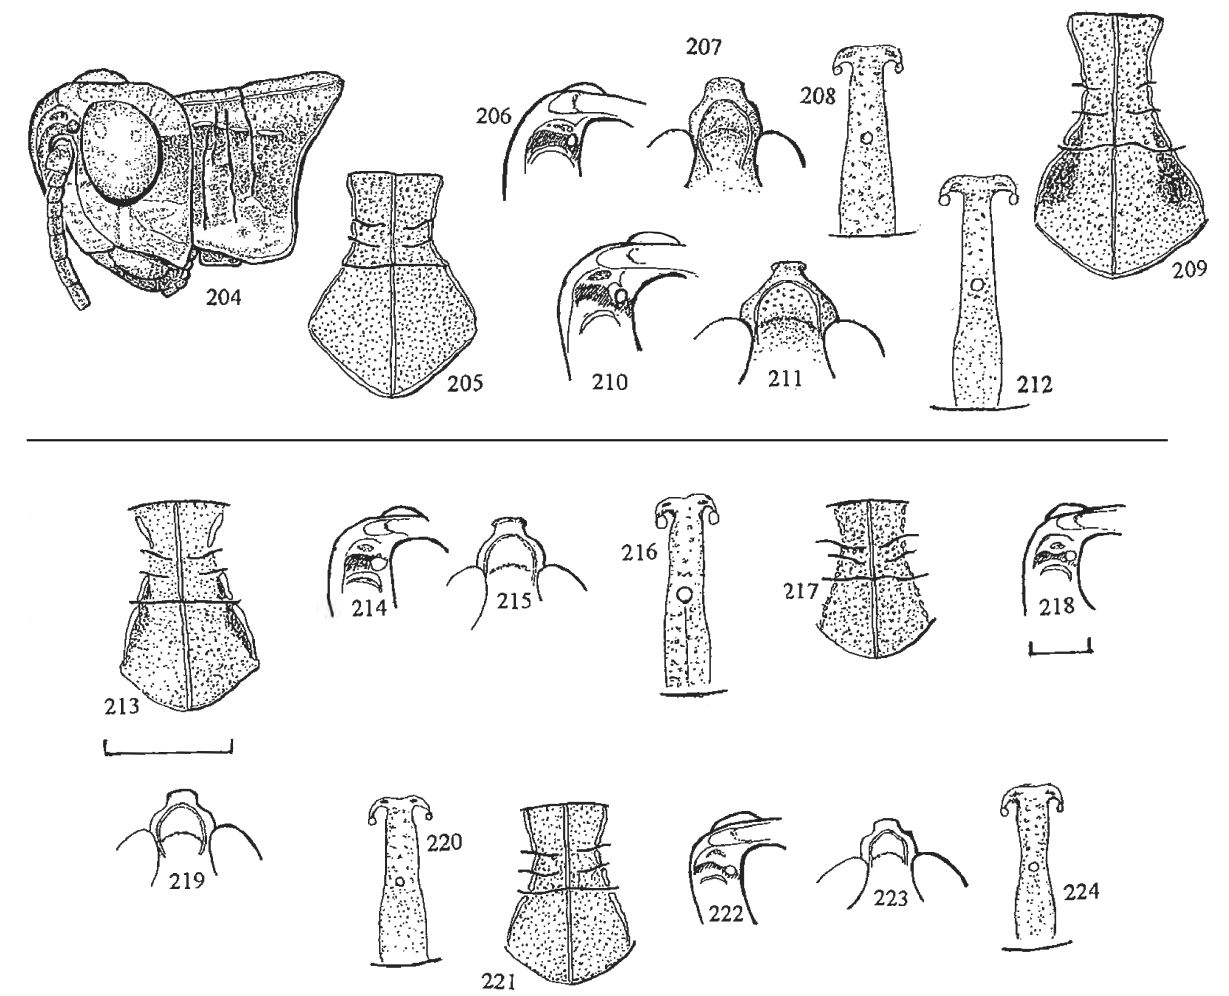
Figs 204–224. Tribe Gymnobothrini. Figs 204–212. Gymnobothrus temporalis male: 204. Oblique view head and pronotum. (205–208, topotype material temporalis from Namibia; 209–212, topotype material emini , D.R. Congo). 205, 209. Pronotal disc; 206, 210. Oblique view vertex; 207, 211. Dorsal view vertex; 208, 212. Frontal ridge. Figs 213–224. Gymnobothrus flexuosus male: (213–216, brevipennis ; 217–220, Ethiopia, Wardere; 221–224, Angola). 213, 217, 221. Pronotal disc; 214, 218, 222. Oblique view vertex; 215, 219, 223. Dorsal view vertex; 216, 220, 224. Frontal ridge. Scale lines are all l mm: that under Fig. 218 applies to Figs 204, 205, 209, 213, 217, 221; that under Fig. 213 applies to Figs 206–208, 210–212, 214–216, 218–220 and 222–224. Gymnobothrus subcarinatus (= Pseudochirista subcarinata I. Bolívar, 1922), type female. ETHIOPIA: Burka, MNHN, Paris. syn.